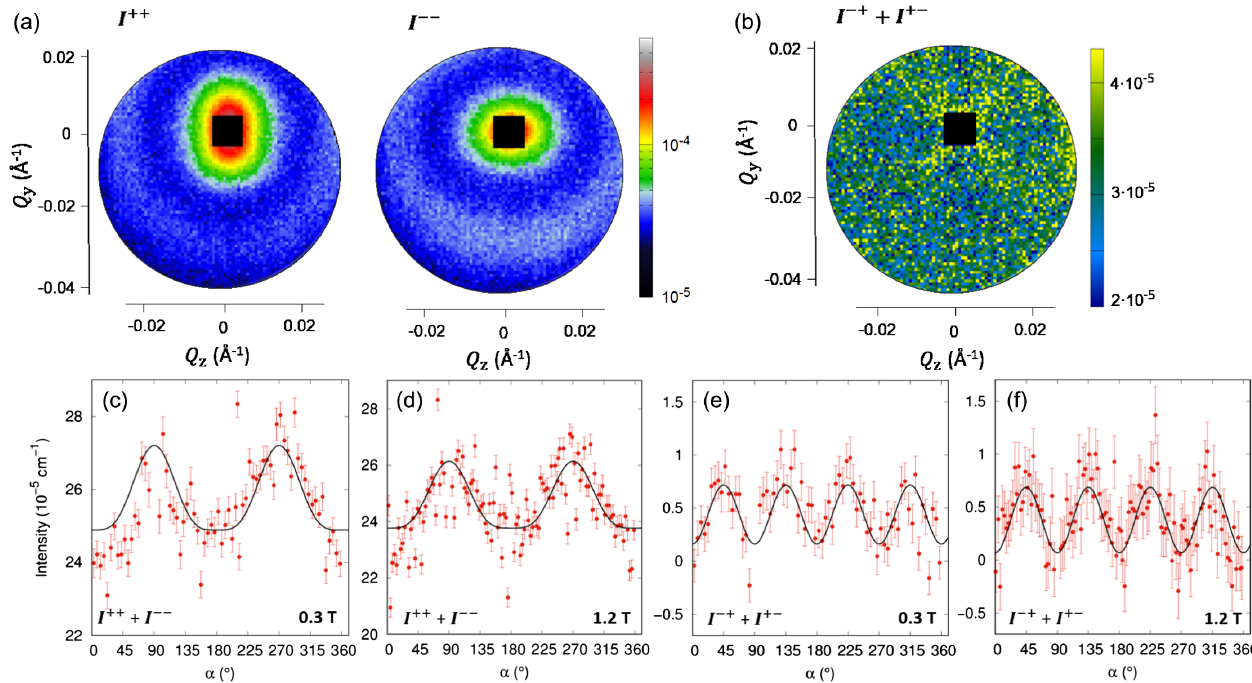
FIG. 4. Spin-resolved SANS (POLARIS) by cobalt ferrite nanoparticles: (a) non-spin-flip (NSF) ( I þþ ; I −− ) and (b) averaged spin-flip (SF) ½ð I þ − þ I − þ Þ = 2 (cid:2) 2D scattering cross sections at an applied magnetic field of 1.2 T. (c) – (f) NSF and SF azimuthal scattering intensities, radially averaged in a Q range of 0 . 006 – 0 . 016 Å − 1 , recorded at 0.3 and 1.2 T with corresponding fits (black